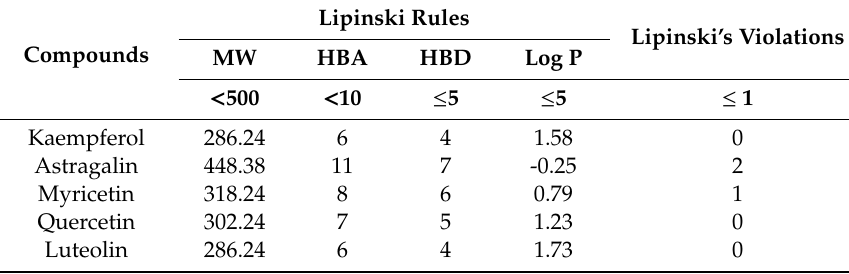
Table 5. Physicochemical properties of the compounds for good oral